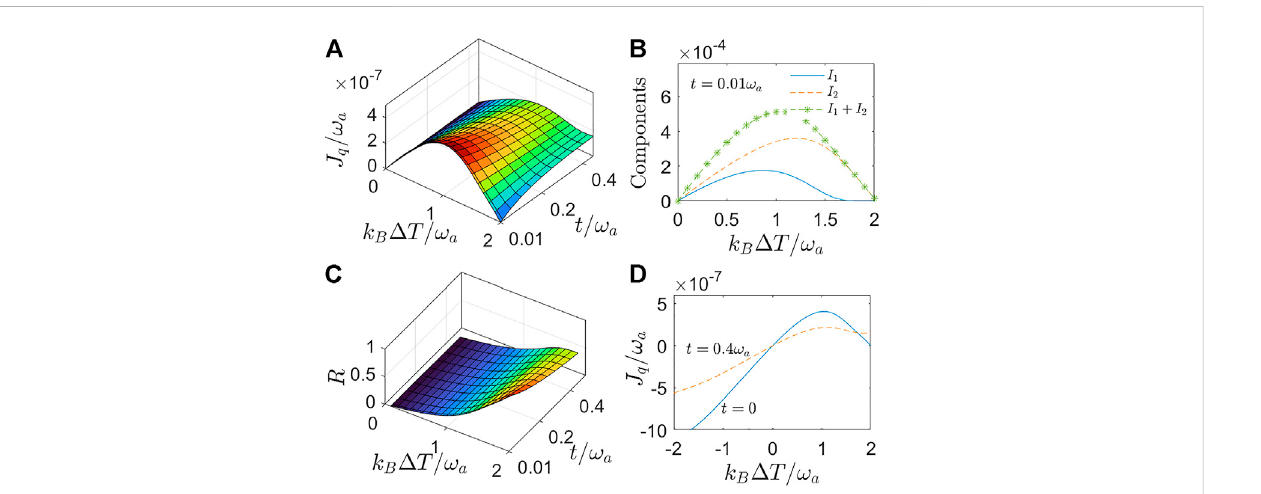
FIGURE 3 (Color online) (A) Steady-state heat current into the q -th reservoir J q / ω a ; (B) current components I 1 (20a), I 2 (20b), and I 1 + I 2 as functions of k B Δ T / ω a at t = 0.01 ω a ; (C) thermal recti fi cation factor R as a function of the temperature bias and resonator-resonator coupling strength; (D) the asymmetric behavior of heat current J q / ω a by tuning k B Δ T / ω a . Other system parameters are given by ω 1 = ω 2 = ω a , ε = ω a , λ 1 = λ 2 = 0.01 ω a , α 1 = α 2 = 0.001 ω a , ω c = 20 ω a , T r = ω a / k B + Δ T /2, and T q = ω a / k B − Δ T